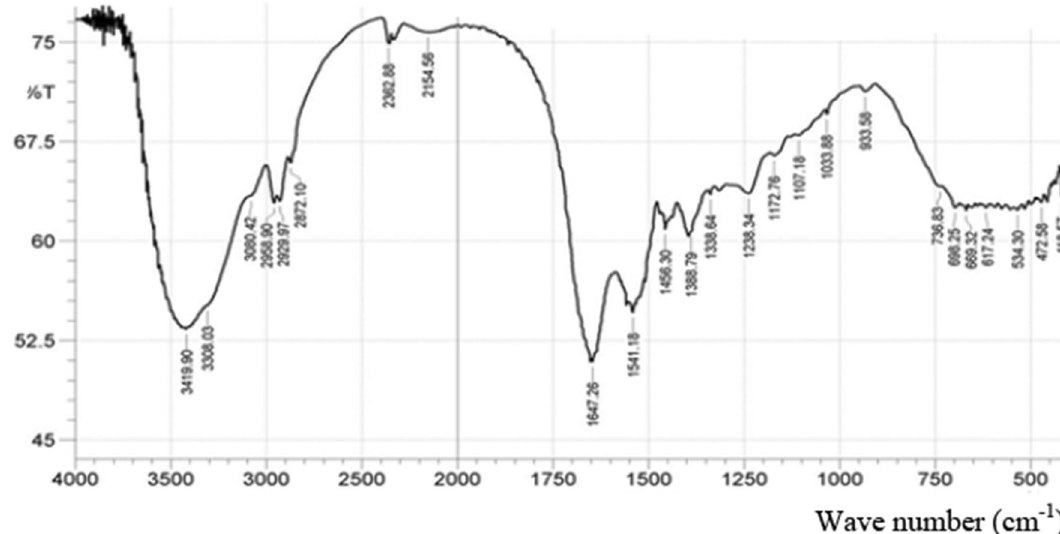
Fig. 3 FTIR spectrum of MSC before adsorption of CR dye